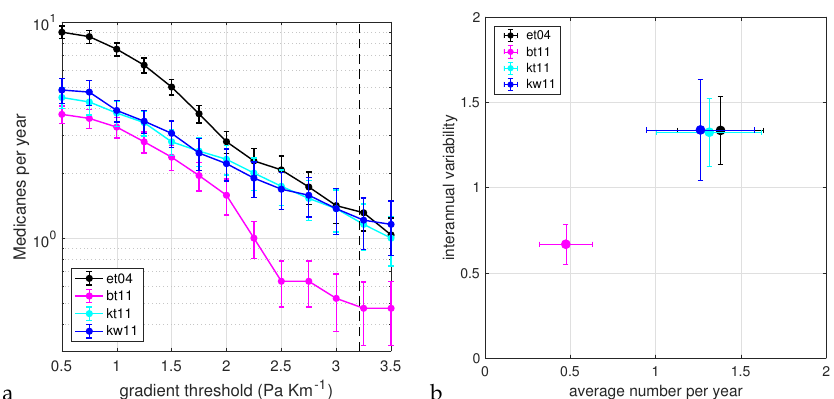
Figure 3. ( a ) Average number per year of detected Medicanes as a function of the sea level pressure gradient in the tracking algorithm. The average for each year is taken over the Medicane season, that is, the period from August to July of the following year. The dashed line indicates the value of 3.21 × 10 − 2 hPa km − 1 commonly used in the literature and also in this study for the detection of Medicanes. ( b ) Scatter plot of the average number per year of Medicanes detected with a pressure gradient value of 3.21 × 10 − 2 hPa km − 1 and interannual variability. The error bars represent the standard deviation of the distribution of values obtained by bootstrap resampling 10,000 time series starting from the original